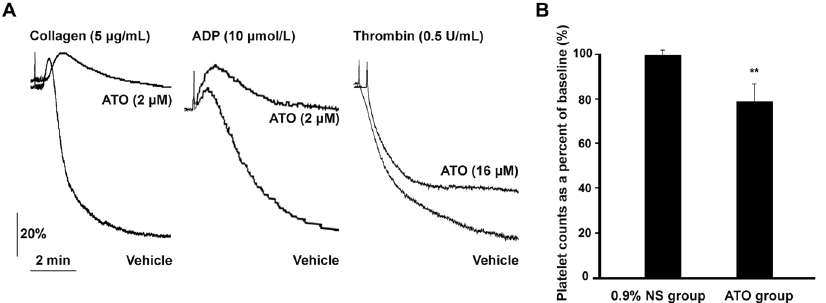
Figure 6. ATO reduces collagen, ADP, and thrombin induced platelet aggregation, and intraperitoneal injection of ATO reduces circulating platelets. (A) PRP was incubated with ATO (2 m M) or vehicle for 1 hr, washed platelets was incubated with ATO (16 m M) or vehicle for 2 hrs. Platelet aggregation assay was performed by addition of collagen (5 m g/mL) or ADP (10 m mol/L) into PRP, or thrombin (0.5 U/mL) into washed platelets under stirring condition, and recorded by a turbidometric platelet aggregometer. Results are representative of 3 separate experiments with different donors. (B) Two groups of mice were intraperitoneally injected with ATO (dissolved in 0.9% NS, 5 mg/kg) or vehicle once a day for 5 continuous days. Blood samples were taken from the mice before injection and 24 hrs after the final injection, and then subjected to platelet count assay using Sysmex KX-21N Blood Cell Analyser. Platelet count (% of baseline) equals platelet count after injection/platelet count before injection 6 100%. Quantitation data from 12 mice per group are illustrated as mean 6 SD. ** P , 0.01, compared with vehicle controls.